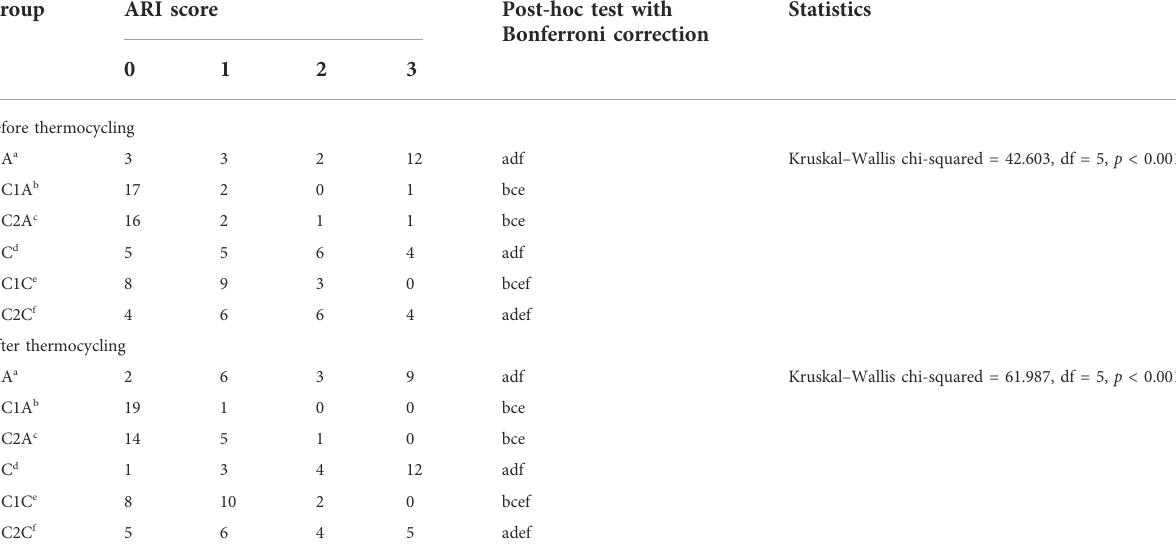
Statistics Bonferroni correction